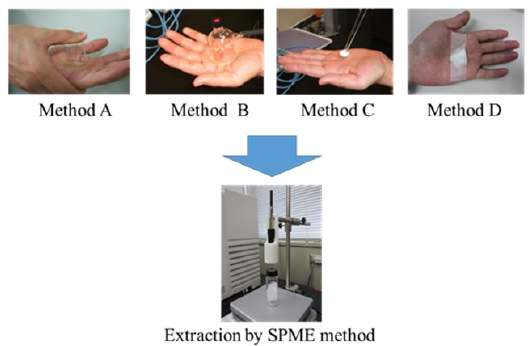
Figure 7. Sampling methods of skin emissions and secretions.